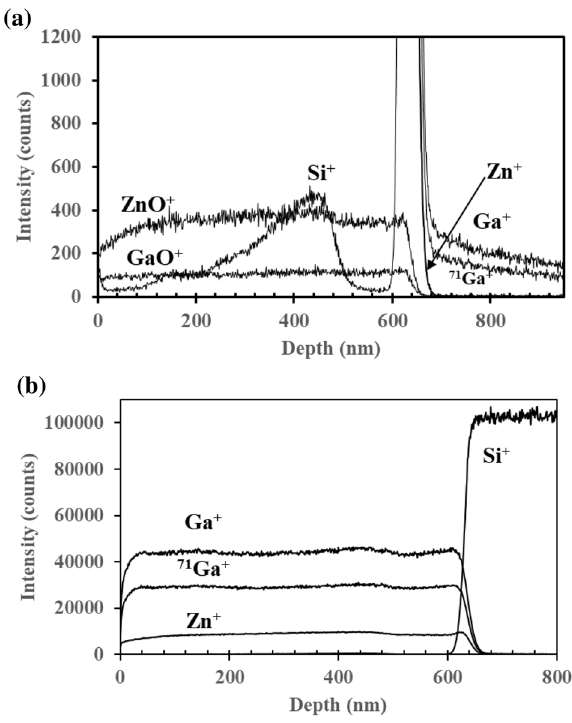
Figure 3. Depth profile analysis of ( a ) low intensity Si + , ZnO + , GaO + ions and ( b ) high intensity Zn + , Ga + and 71 Ga +